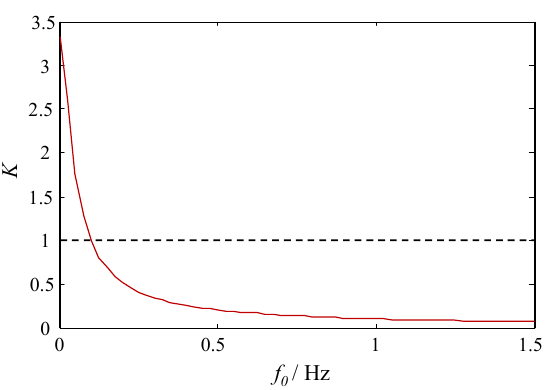
Figure 1. The response amplification value K of the classical stochastic resonance (CSR) system versus the frequency f 0 .